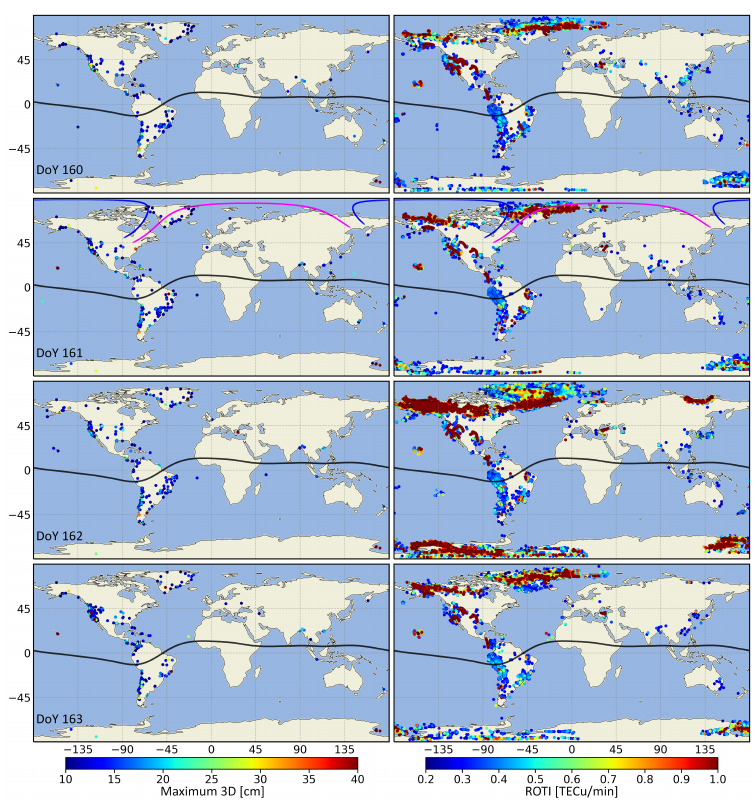
Figure 6. Maximum 3D positioning errors (cid:62) 10 cm ( left panels ); and ROTI (cid:62) 0.25 TECu/min ( right panels ) between 8 and 14 UT. From top to bottom shows DoYs 160–163. Annular eclipse path at ground level (blue line), and at 350 km of altitude (magenta line) are also